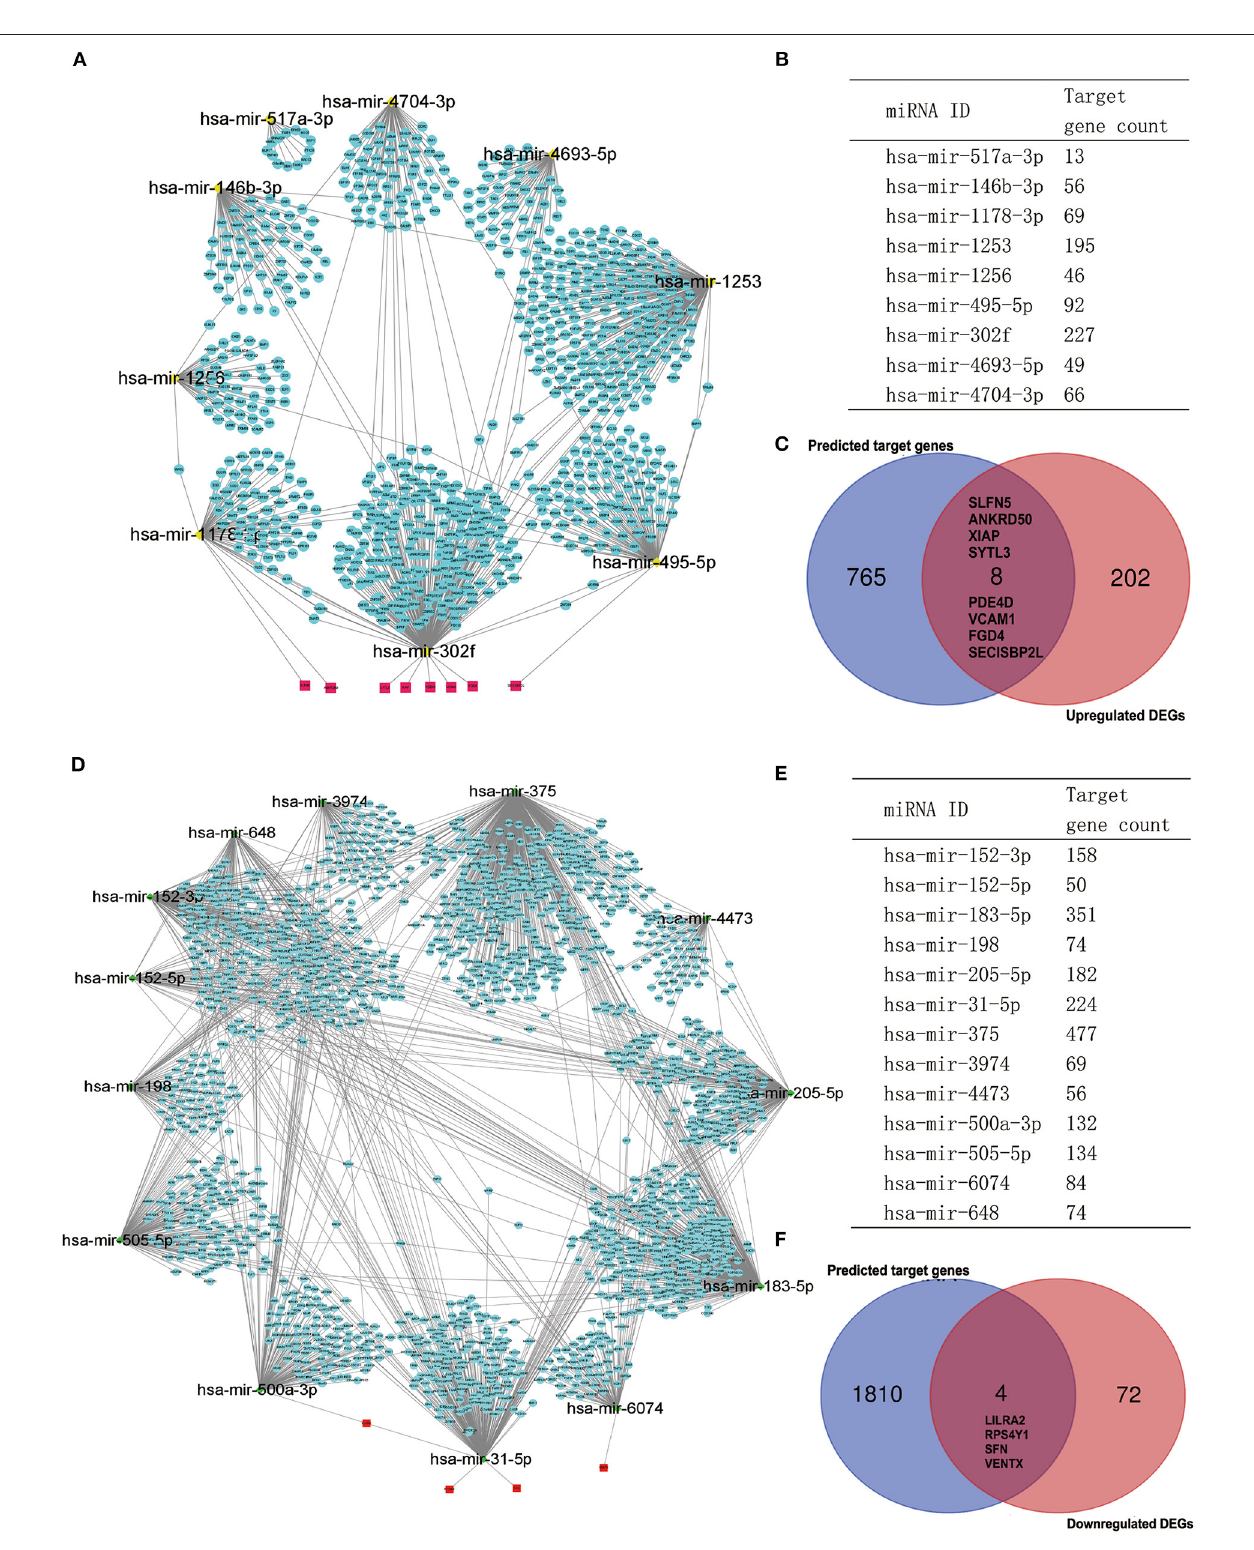
FIGURE 6 | Potential target genes of DE-miRNAs predicted by miRNet database. (A) The network of downregulated DE-miRNAs and predicted target genes. (B) Predicted target gene count for each downregulated DE-miRNAs. (C) The Venn gram of predicted upregulated target genes and upregulated DEGs from RRA analysis. (D) The network of upregulated DE-miRNAs and predicted target genes. (E) Predicted target gene count for each upregulated DE-miRNAs. (F) The Venn gram of predicted downregulated target genes and downregulated DEGs from RRA analysis. DE-miRNAs, differentially expressed miRNAs; DEG, differentially expressed gene; RRA, robust rank